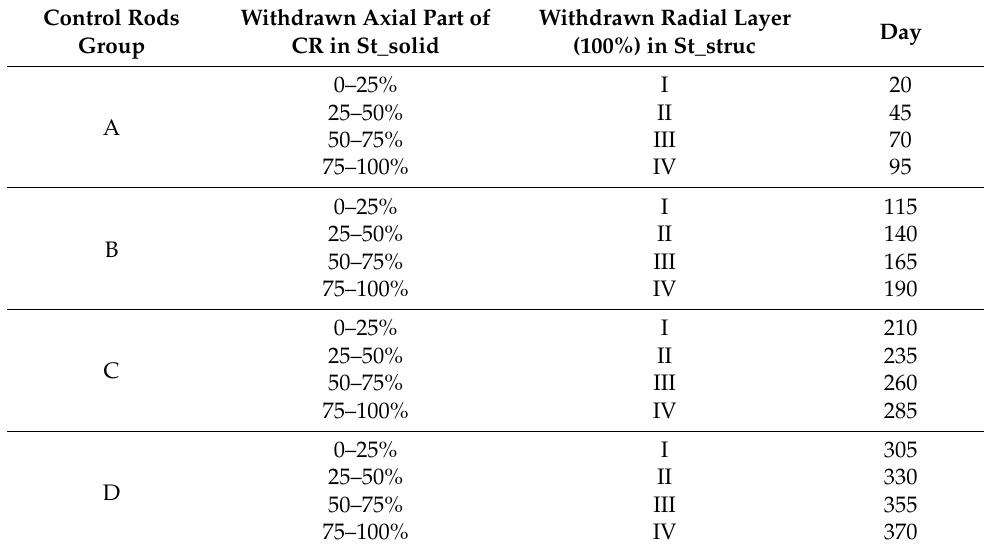
Table 2. Specification of St_solid and St_struc control rod operation strategies.